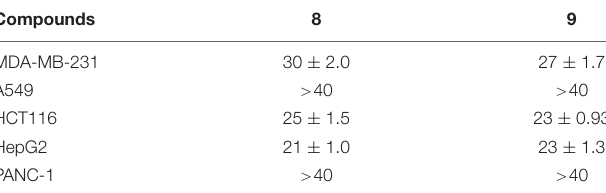
TABLE 3 | Cytotoxicities (IC 50 , µ M) of compounds 8 and 9